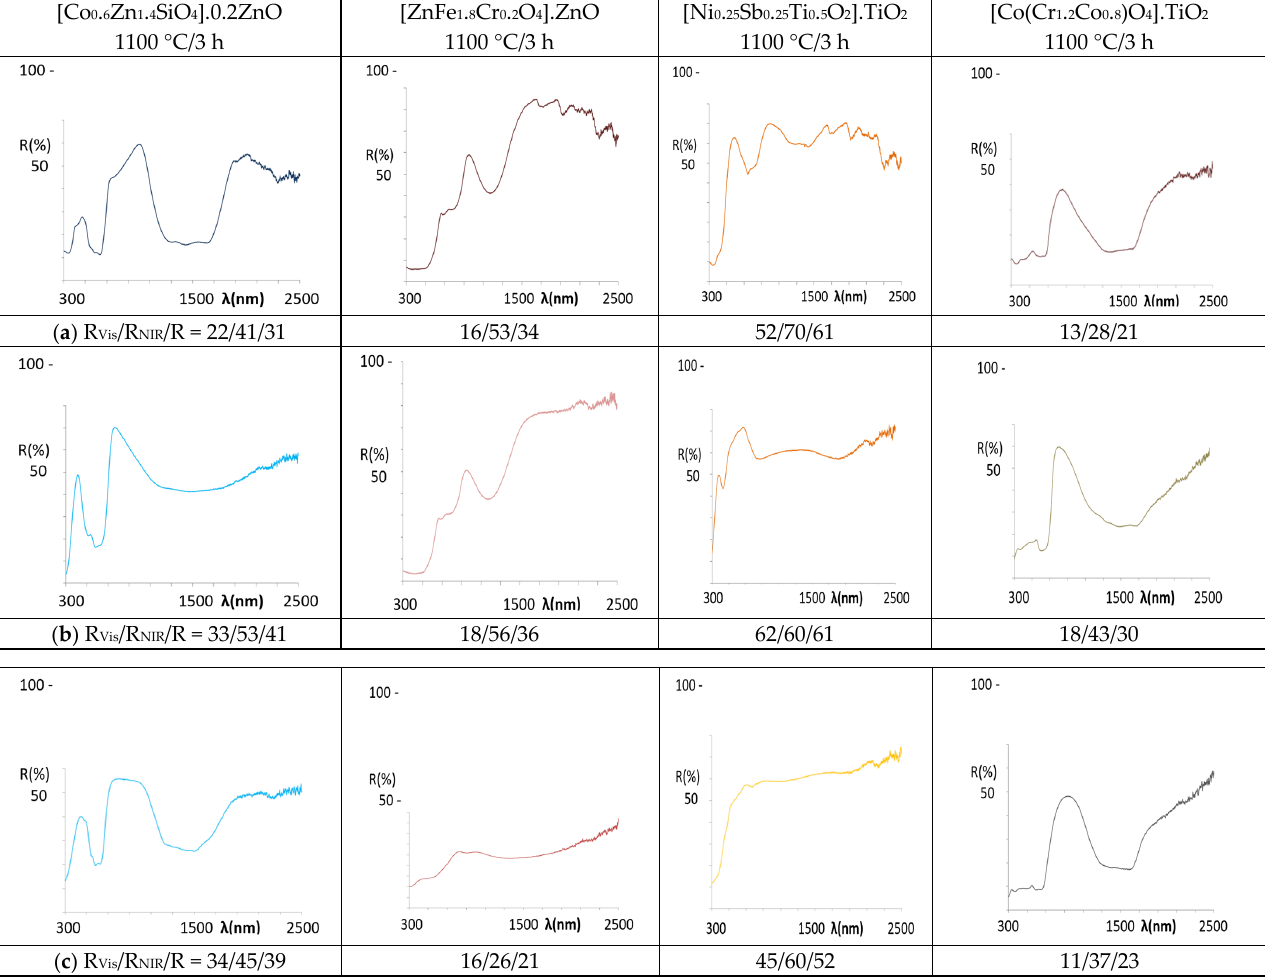
Figure 12. UV-Vis-NIR reflectance spectra of classical pigment applications: ( a ) 10 wt% in colourless alkyd paint, ( b ) 3 wt% in double firing frit (1050 °C), ( c ) 2% wt% in porcelain powder (1190 °C). alkyd paint, ( b ) 3 wt% in double firing frit (1050 ◦ C), ( c ) 2% wt% in porcelain powder (1190 ◦